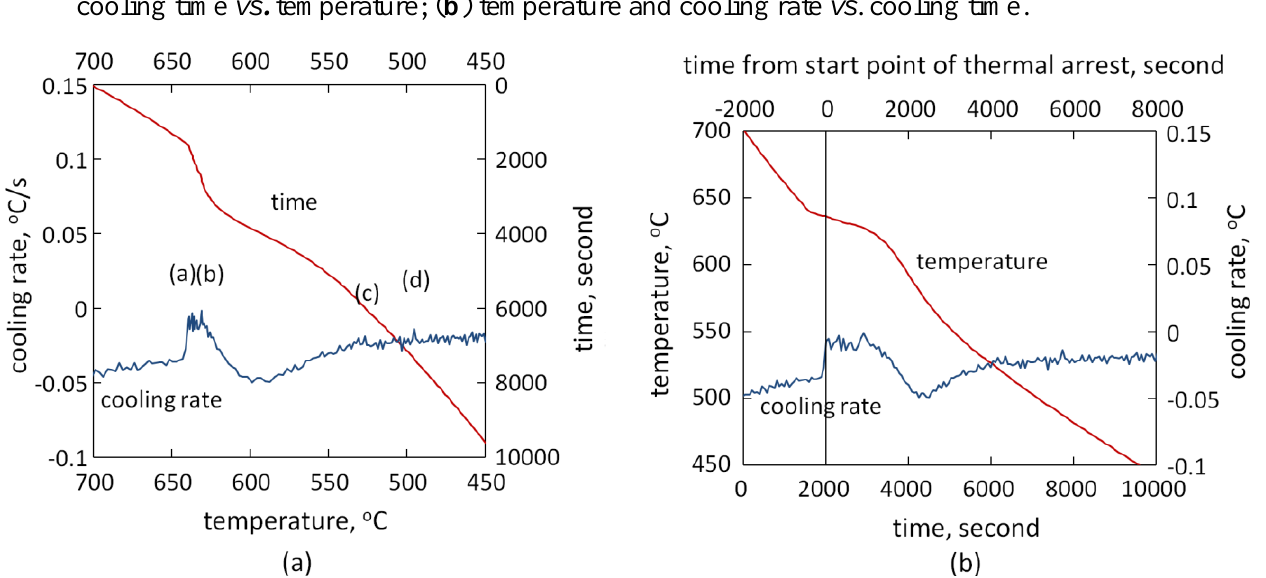
Figure 5. Thermal analysis curve and its first derivation of Sample FC: ( a ) cooling rate and cooling time vs. temperature; ( b ) temperature and cooling rate vs . cooling